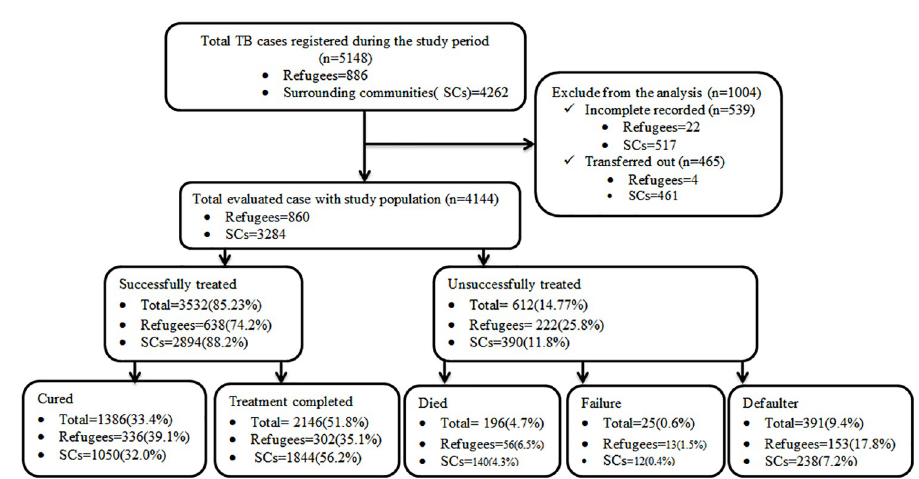
Fig 1. Number registered TB patients and treatment outcomes among refugees and surrounding communities during September, 2009- October, 2017 in Gambella Regional State, South West Ethiopia. Note: TB, Tuberculosis; SCs, surrounding communities. There were difference in the treatment outcome (X2 = 170.915; P < 0.0001) and success rate (X2 = 92.887; P < 0.0001) between the two study populations.